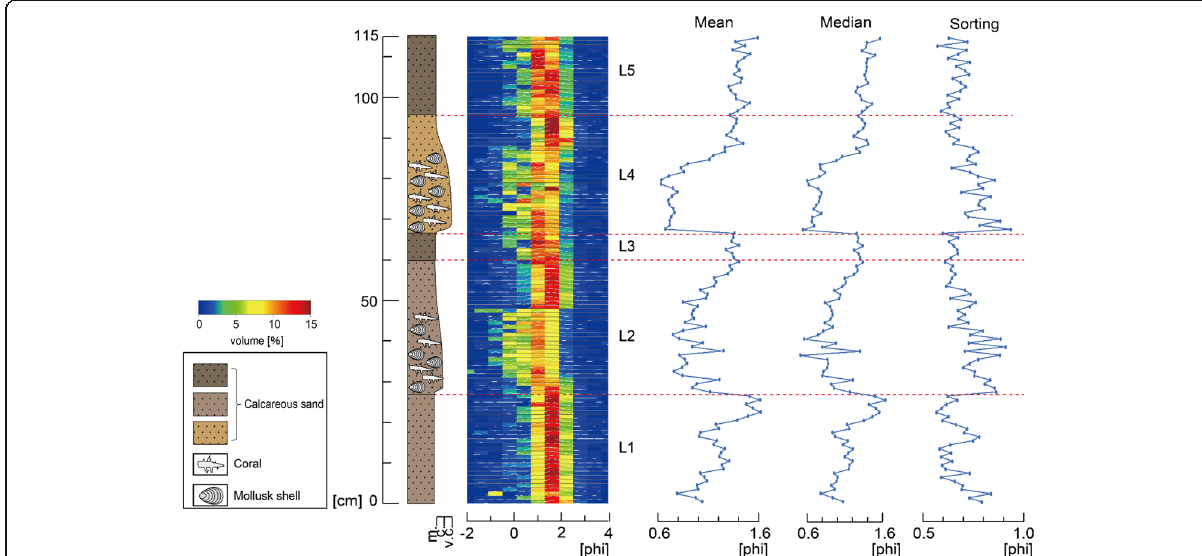
Fig. 5 Logs of lithology and grain size. Colors of the lithologic log roughly correspond to the actual color of L1 to L5 (see also Fig. S1): m, medium sand; c, coarse sand; v.c., very coarse sand. Mean and median grain sizes and sorting are